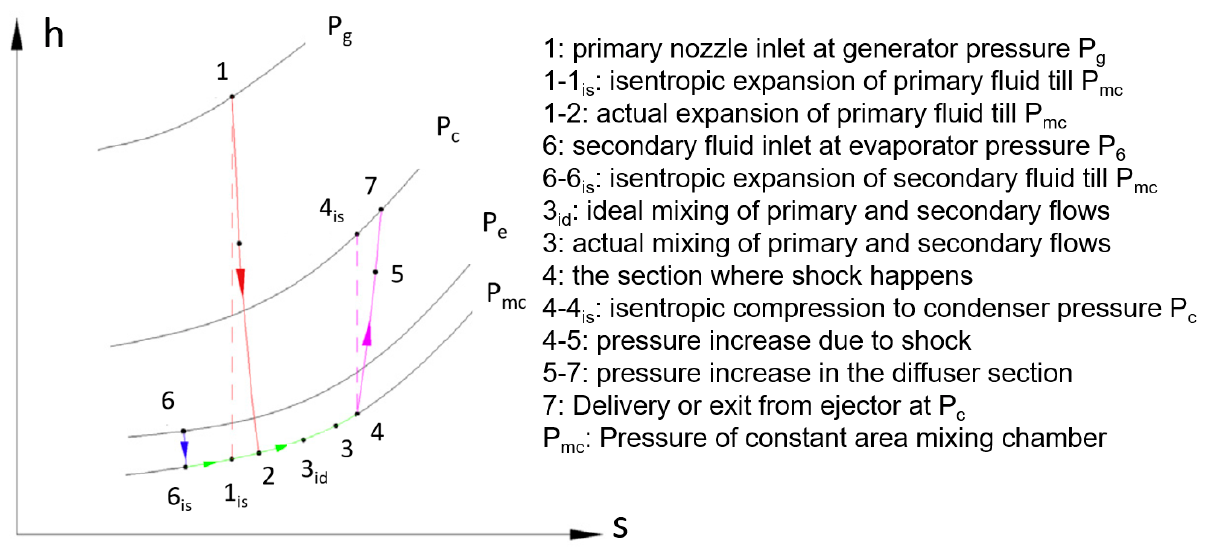
Figure 2. Enthalpy–Entropy diagram for ejector’s thermal processes. The blue line presents the secondary fluid; the red line represents the primary fluid; the pink color represents the mixed fluid; the green color represents the constant pressure mixing